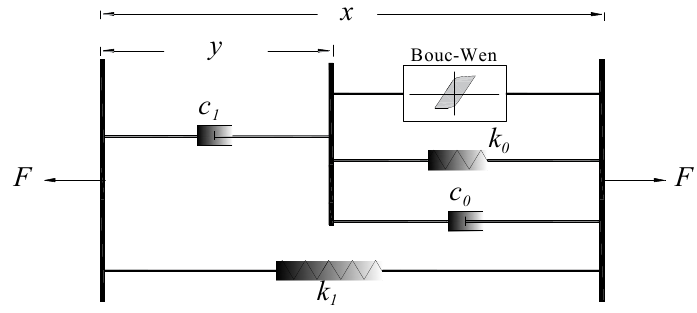
Figure 9. Modified Bouc–Wen model of the magnetorheological (MR) damper (replotted based on Nugroho et al. [41]).